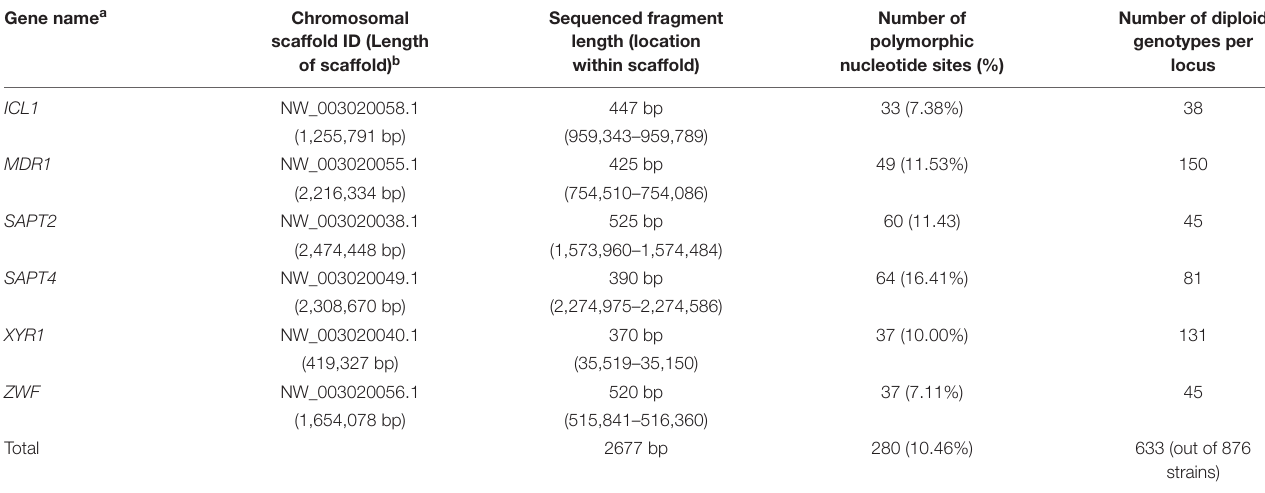
TABLE 2 | Single nucleotide polymorphisms at the six loci in the global sample of C.